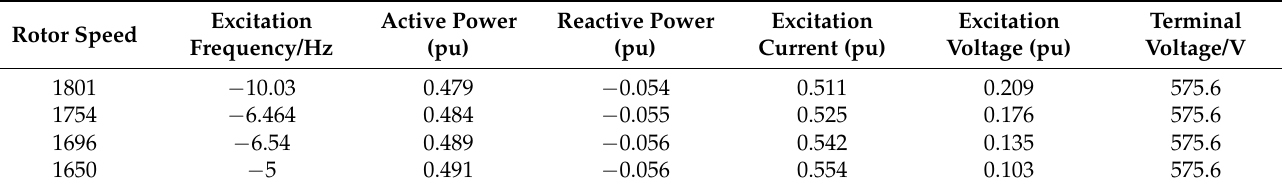
Table 6. The change in rotor speed at a given power at a wind speed of 11 m/s.